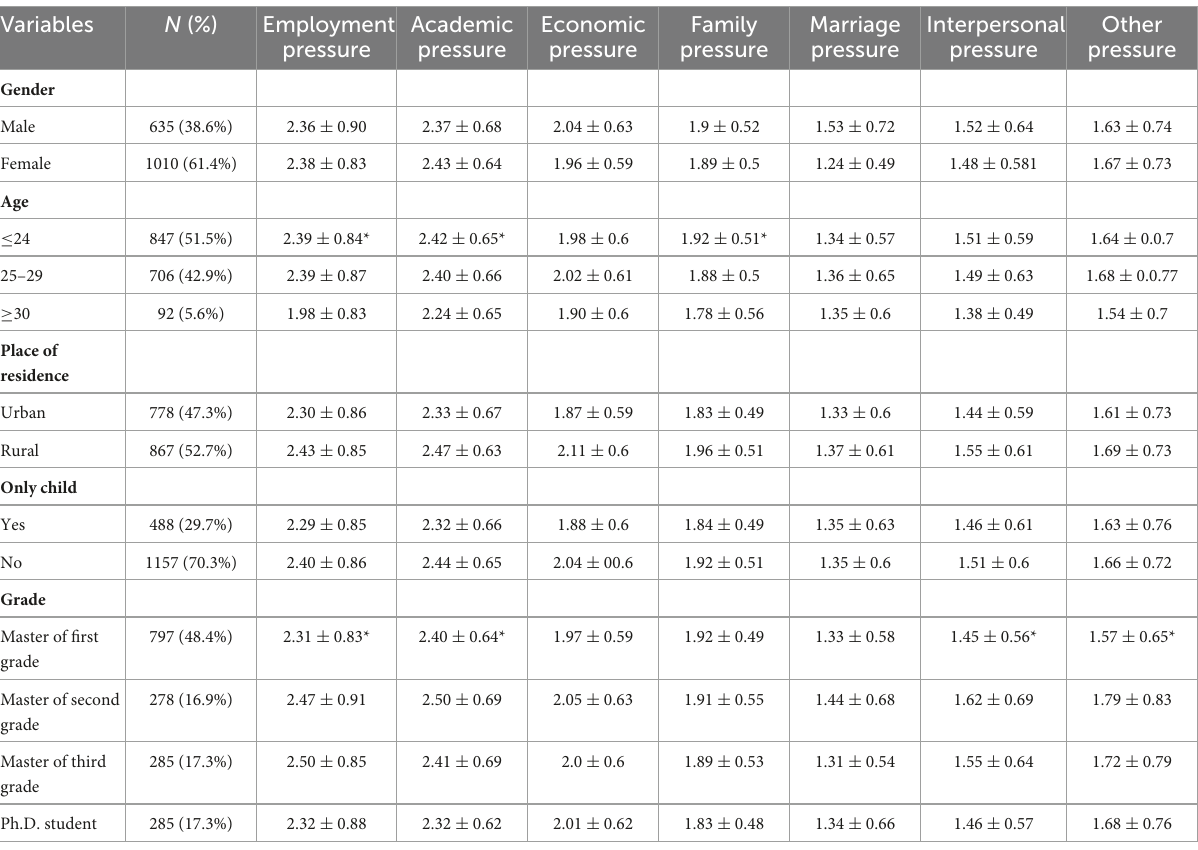
TABLE 2 Comparison of different characteristic stressors among medical postgraduates.